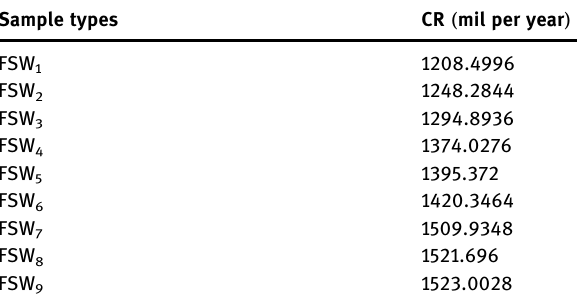
Figure 8: Tafel plots of base metal and FSW 7 , FSW 8 , and FSW 9 samples.